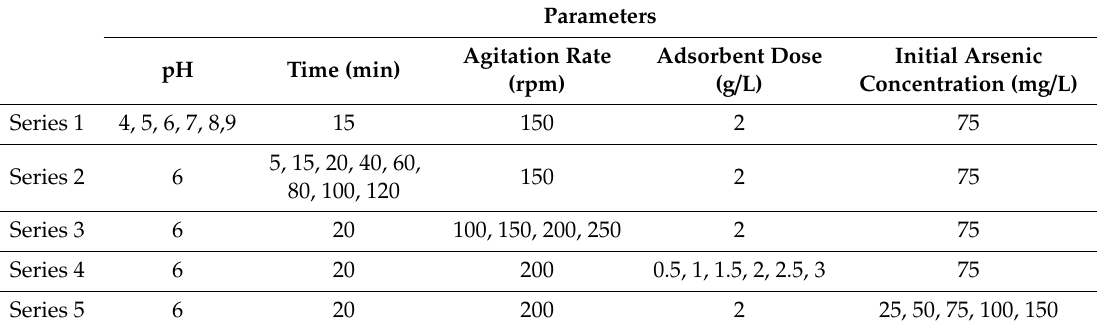
Table 1. Summary of the design of adsorption experiments.